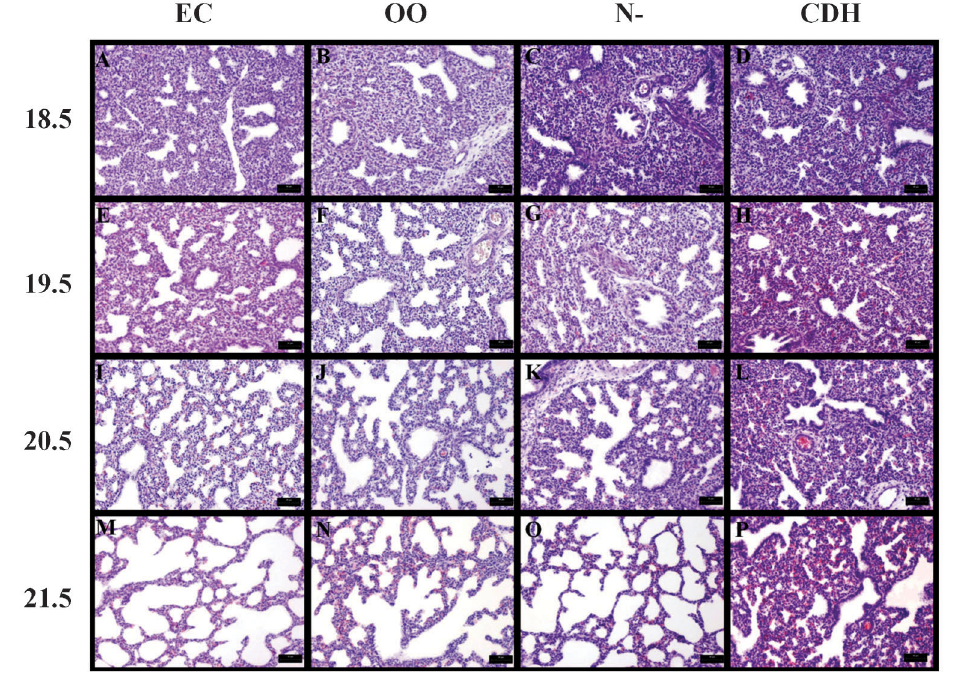
Figure 2. Photomicrographs of fetal lungs from the external control (EC), exposed to olive oil (OO), exposed to nitrofen without CDH (N-), and exposed to nitrofen with congenital diaphragmatic hernia (CDH) groups at gestational days 18.5, 19.5, 20.5, and 21.5. There was a decrease in the airspace in panels H , L , and P , demonstrating pulmonary hypoplasia in the CDH group at later gestational ages. H&E staining, bars: 50 m